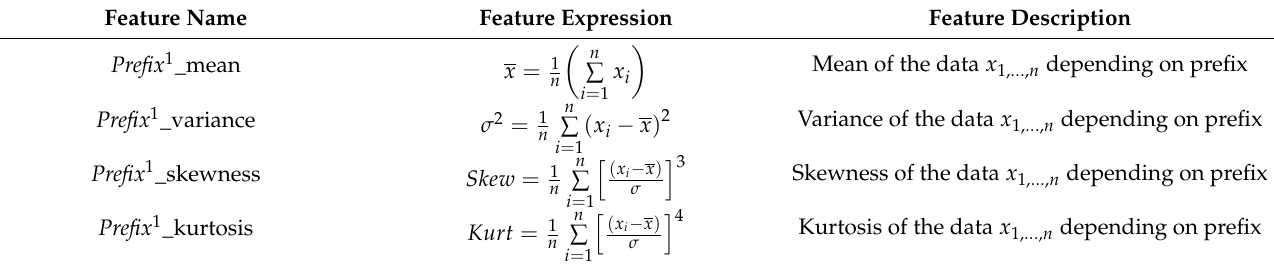
Table A2. Image features based on statistical characteristics.